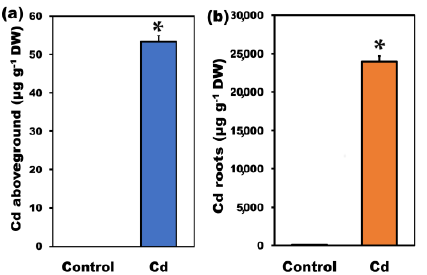
Figure 1. Changes of Cd accumulation in aboveground (shoots-leaves) tissues ( a ) and roots ( b ), in µg g −1 dry weight, after 5 days Cd treatment of Salvia sclarea plants. Error bars are standard deviations ( n = 5). Means between the two treatments that are statistically different ( p < 0.05) are marked by an asterisk (*).